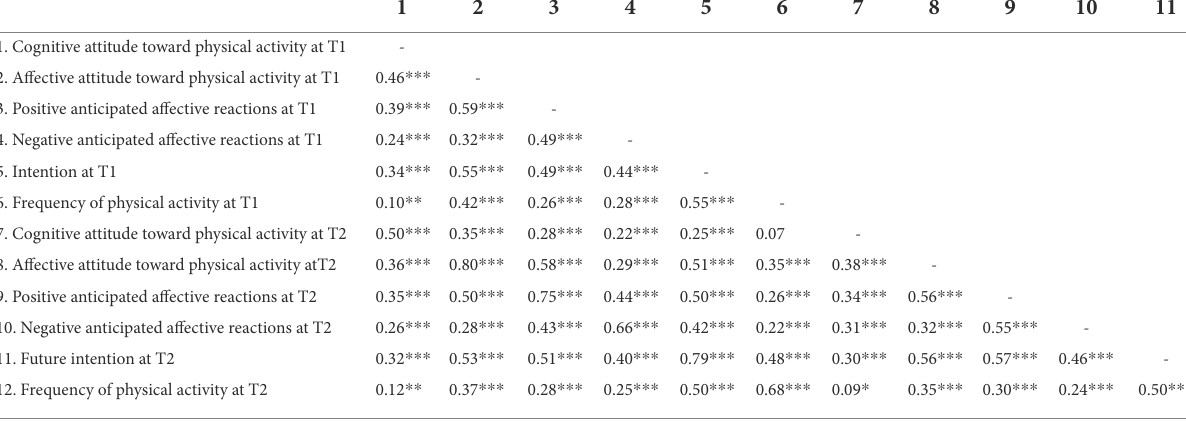
TABLE 4 Correlations among study variables before and after the message